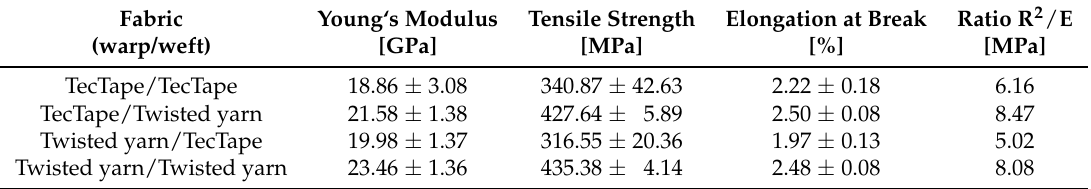
Table 3. Experimental results from tensile tests for flat plate specimens with a confidence interval (CI) of